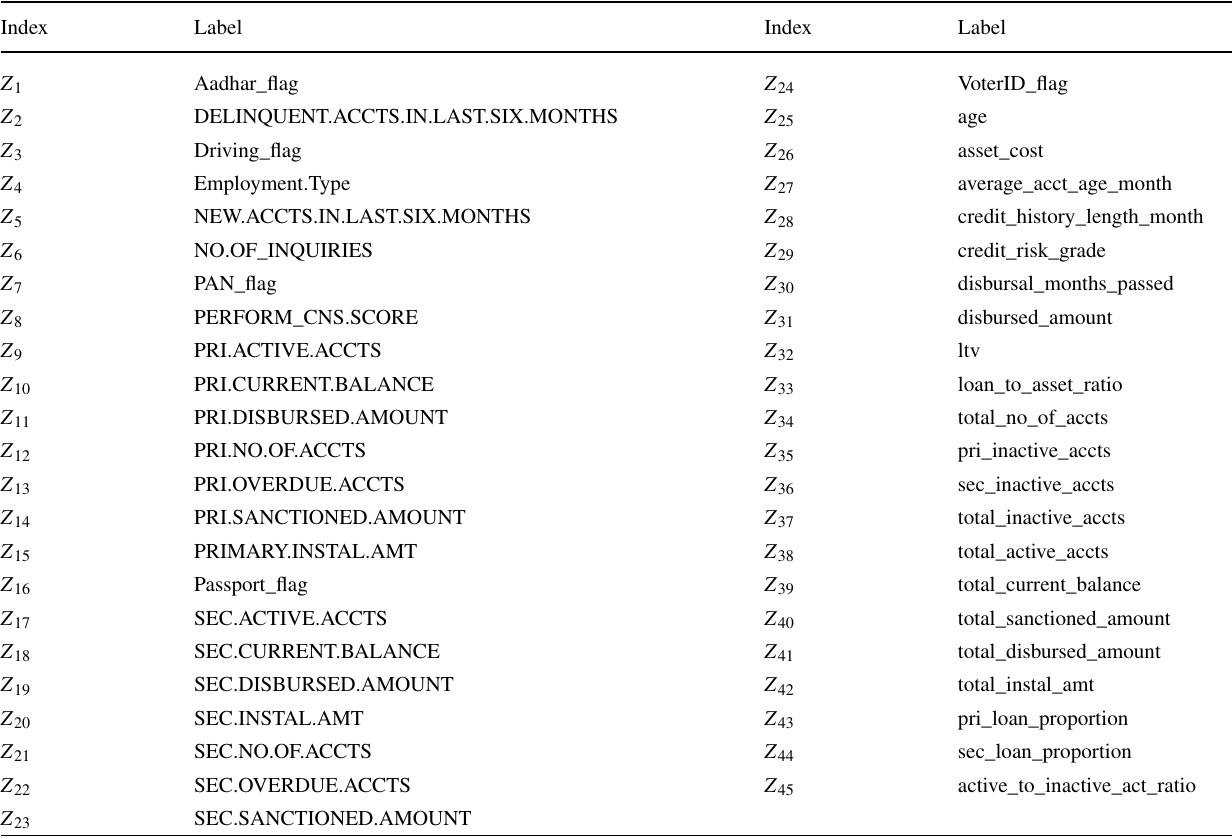
Table 4 Resulting credit risk assessment